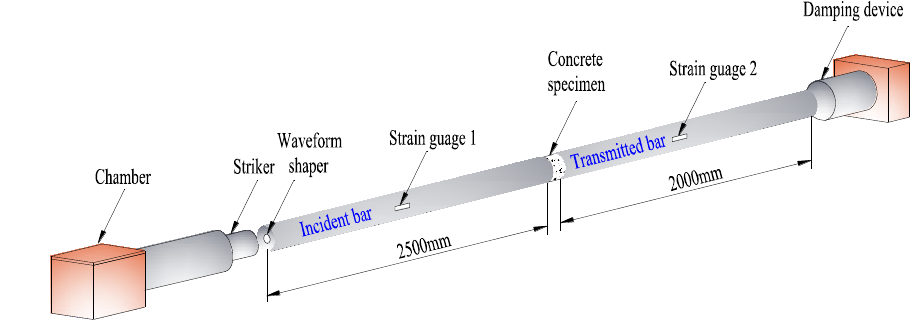
Figure 3. Schematic diagram of separated Hopkinson pressure bar (SHPB) device.